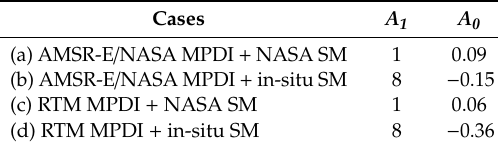
Table 3. Values of A 0 and A 1 parameters (see text for details on the estimation procedure).